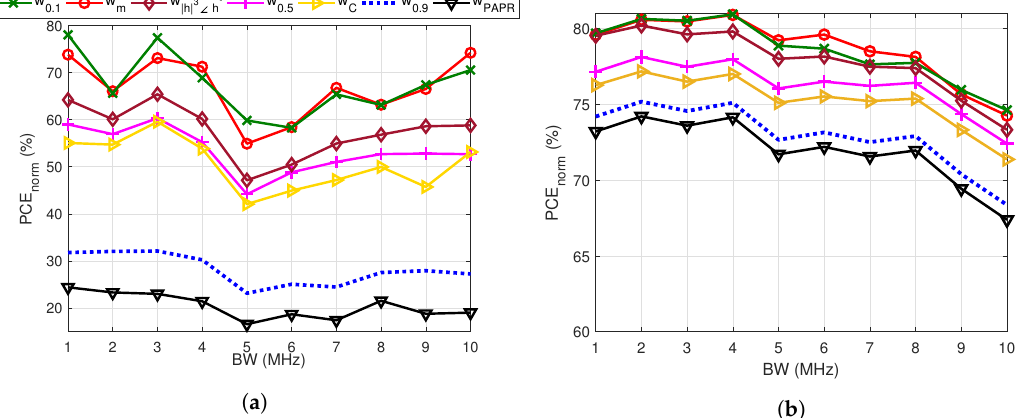
Figure 8. ( a ) Simulated and ( b ) measured normalized PCE with increasing BW using the proposed pre-equalizers of a two-tone based SWIPT system with ρ = 0.9.